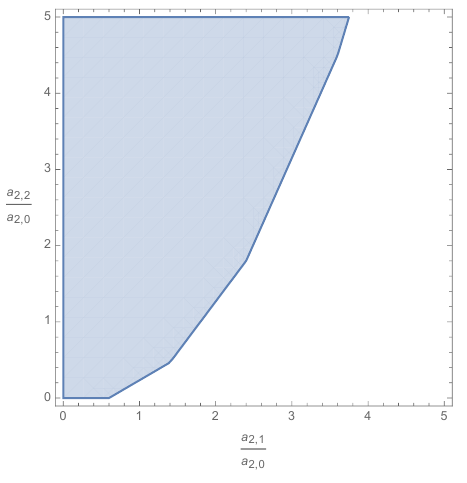
Figure 14 . The k = 2 polygon for (+ − + − ) gluon